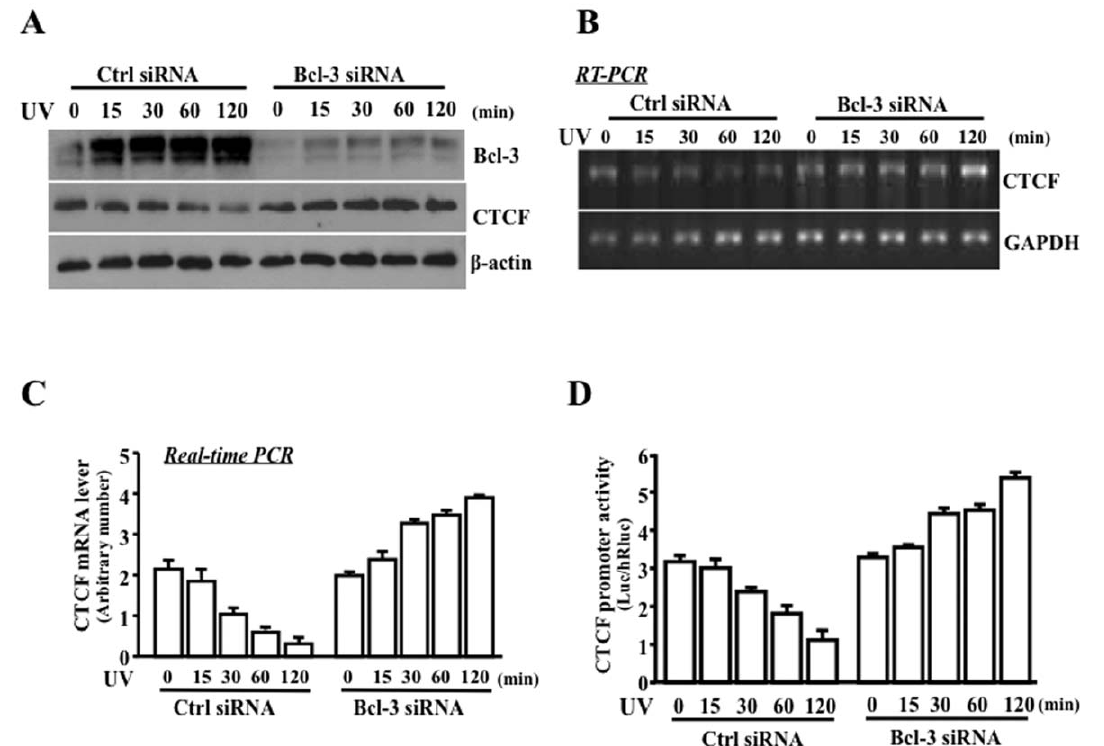
Figure 4. Effects of knocking down Bcl-3 on UV stress-induced suppression of CTCF. (A) Time-dependent effect of knocking down Bcl-3 on UV stress-induced suppression of CTCF detected by Western analysis. (B) Time-dependent effect of knocking down Bcl-3 on UV stress-induced inhibition of CTCF mRNA expression by RT-PCR. (C) Quantitative detection of UV stress-induced CTCF mRNA suppression in Bcl-3 knocking down cells by real time PCR. (D) Effect of knocking down Bcl-3 on UV stress-induced suppression of CTCF promoter activity. Data were plotted as Mean 6 SE and statistical significance was determined at p , 0.05 (n=3 to 6).